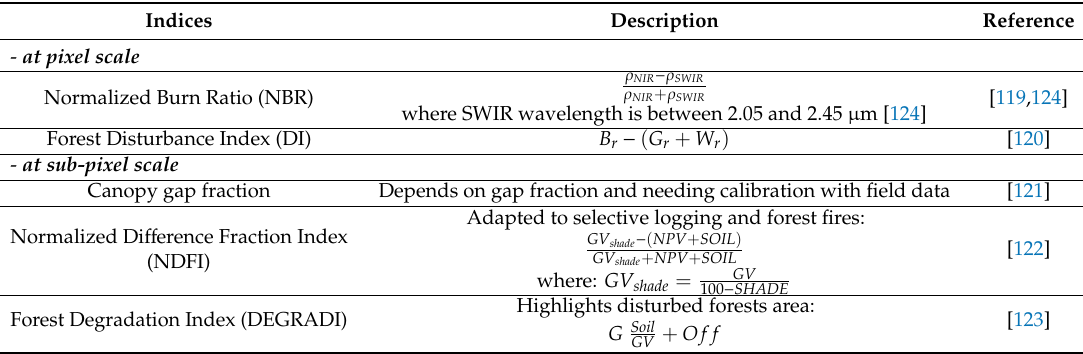
Table 3. Spectral indices used in the detection of tropical moist forest degradation.